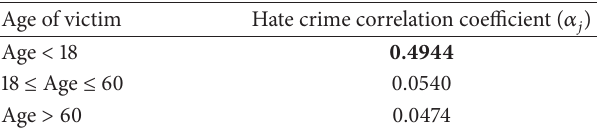
Table 3: Hate crime correlation coefficients for age of victim.